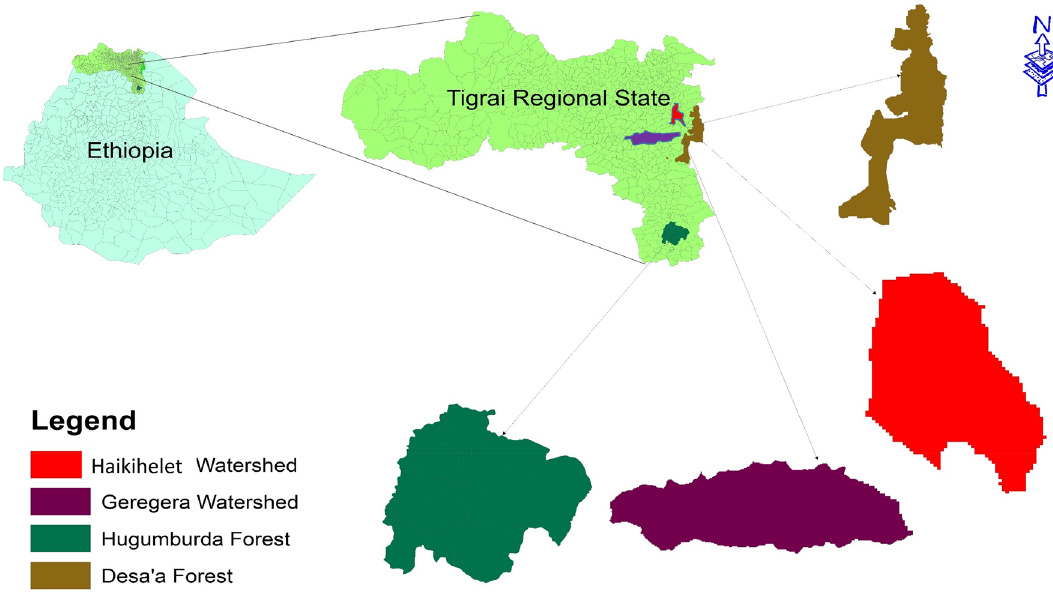
Figure 1. Location map of study area showing the study locations in semi-arid area of northern Ethiopia. Source Authors (ArcMap 10.4).